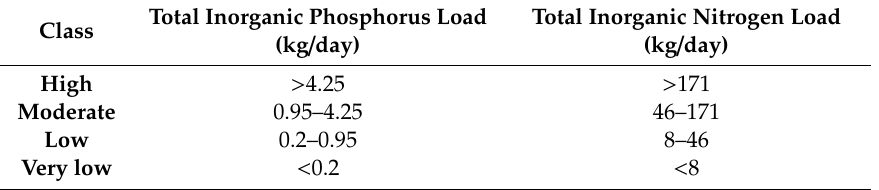
Table 2. Quality classes and thresholds for total inorganic phosphorus and nitrogen